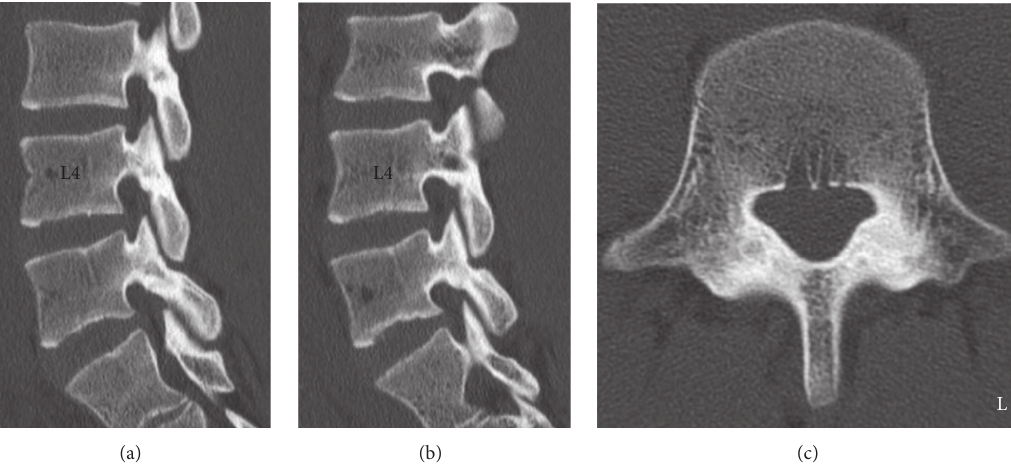
Figure 1: Reconstructed computed tomography (CT) scan of the lumbar spine from the first visit to a previous doctor’s office. (a) Right parasagittal reconstructed CT image. (b) Left parasagittal reconstructed CT image. (c) Axial CT image at L5 level. Fissures (black arrows) in the bilateral pars interarticularis of the L5 can be seen (a, b, c). These radiological findings indicated a bilateral spondylolysis of the L5.